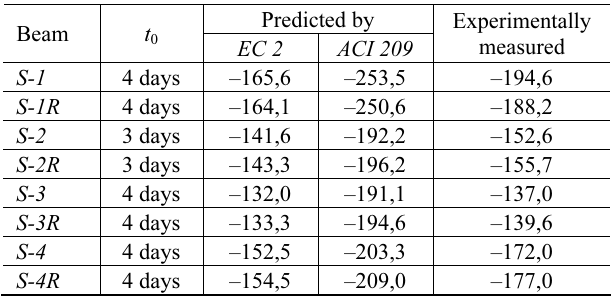
Table 6. Shrinkage deformations of 280 × 300 × 350 mm prisms at test day